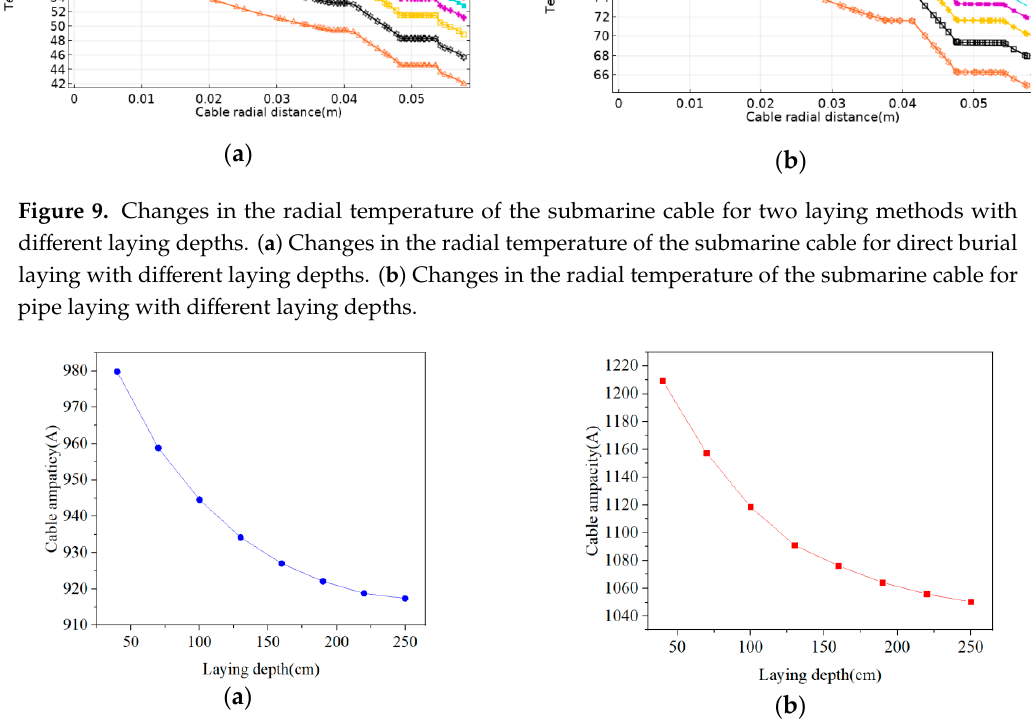
Figure 10. The submarine cable ampacity for two laying methods with different laying depths. ( a ) Submarine cable ampacity for direct burial laying with different laying depths. ( b ) Submarine cable ampacity for pipe laying with different laying depths.